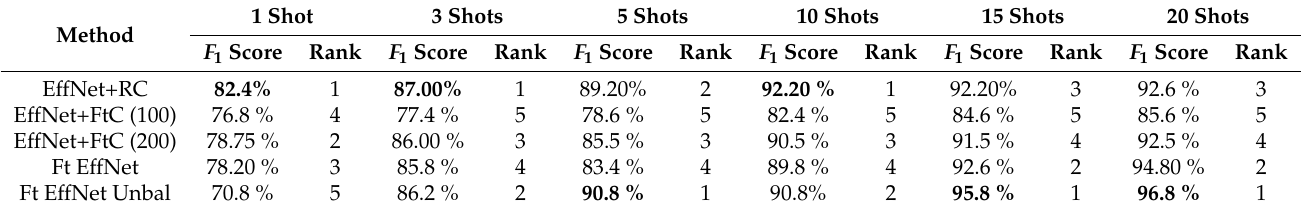
Table 6. The weighted F 1 score and rank of the different classification models evaluated on all classes (base and new). Our values are highlighted in bold.